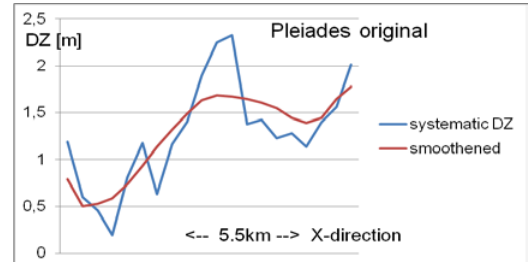
Fig. 11. Systematic height errors in X-direction, Pléiades